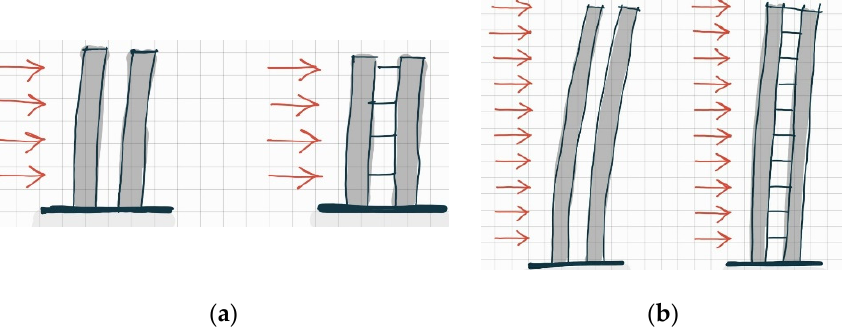
Figure 5. Diagram showing the effect of load pressure on buildings with a case of connected and separated cores to defend against the lateral forces coming from outside. ( a ) Low-rise building, ( b ) high-rise building. Adapted from [24].